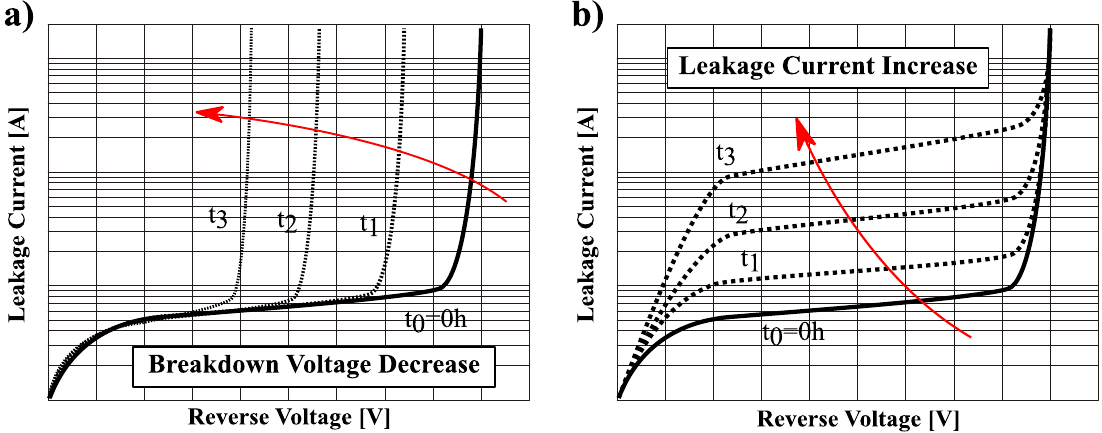
Figure 4. The two main types of electrical degradation of I–V characteristics after HV-THB: Breakdown voltage decrease ( a ), and leakage current increase ( b ) in a generic power semiconductor device.